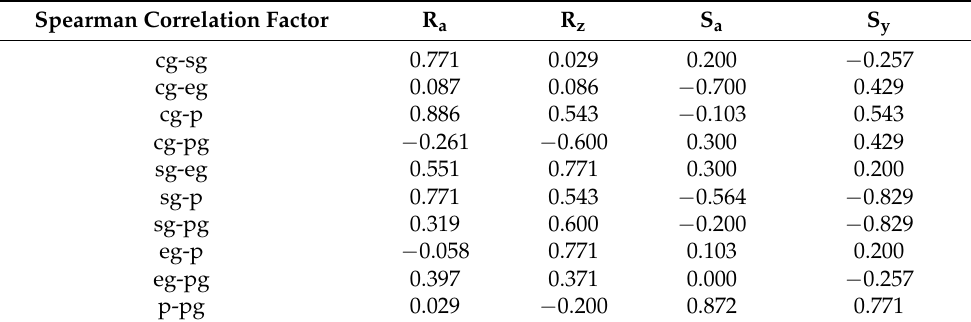
Table 7. Correlation factor values related to conditioning method, after finishing.